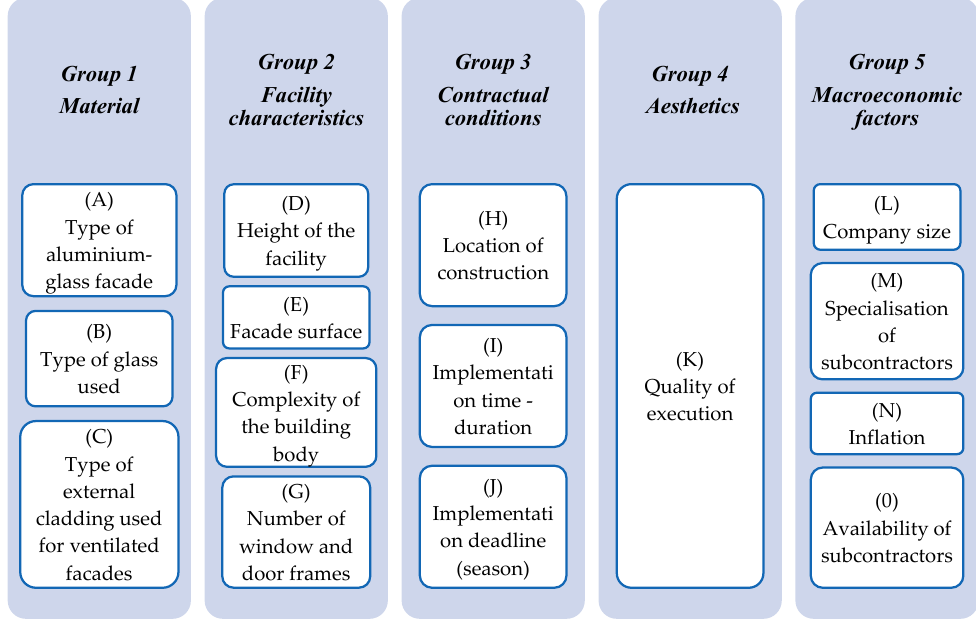
Figure 6. Proposed division of the identified factors.